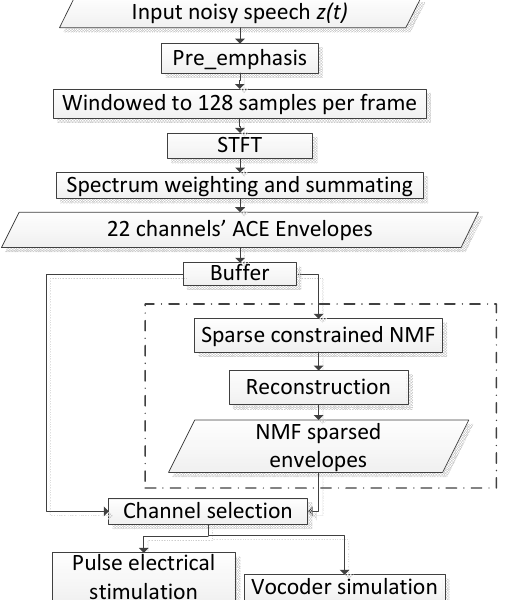
Advanced combination encoder (ACE) strategy and the proposed sparse constrained non-negative matrix factorization (NMF)